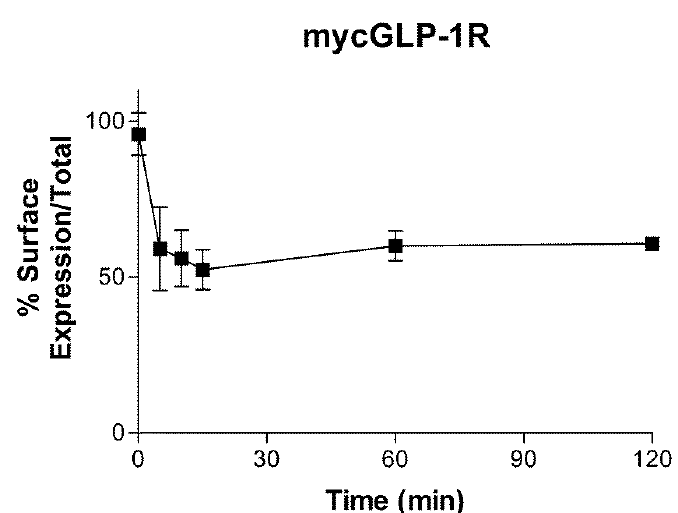
Figure 4. Agonist-induced internalization of mycGLP-1R. Incubation with 1 µM GLP-1 caused a time-dependent loss of cell surface expression of mycGLP-1R. Data are expressed as a percentage of receptor surface expression over total expression at time zero and represent the mean, with the S.E.M. displayed as error bars from three independent experiments.